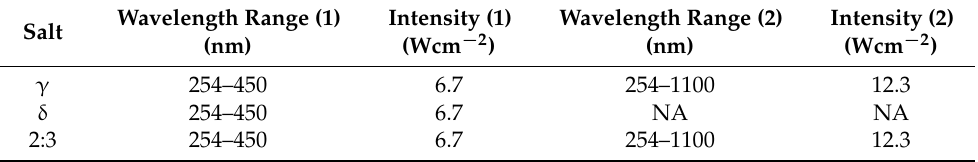
Table 4. Irradiation conditions in photoconductivity measurements.